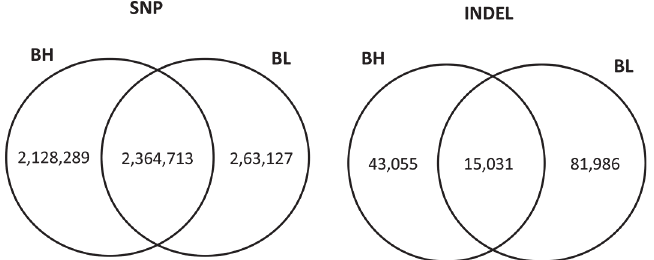
Fig 7. The venn diagram of SNPs and Indels in BH and BL. The number of SNPs and Indels in genome located in BH and BL